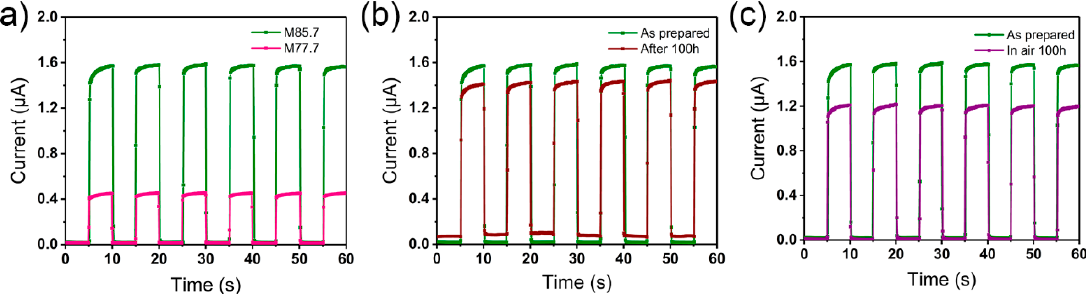
Figure 7. Photoresponse performance of the photodetectors. ( a ) Comparison of photocurrent between M77.7 and M85.7 at 700 nm. ( b ) M85.7 device retained over 85% of its initial responsivity after 100 h exposure to moisture. ( c ) M85.7 device retained nearly 75% of its initial responsivity